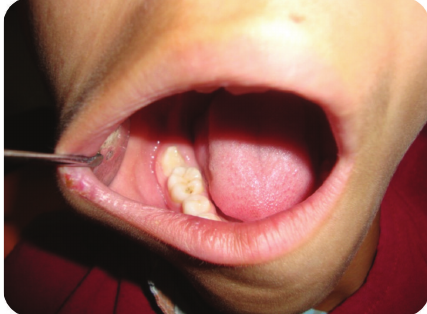
Figure 1: Intraoral operative photograph showing second molar partly covered with pericoronal flap partly.